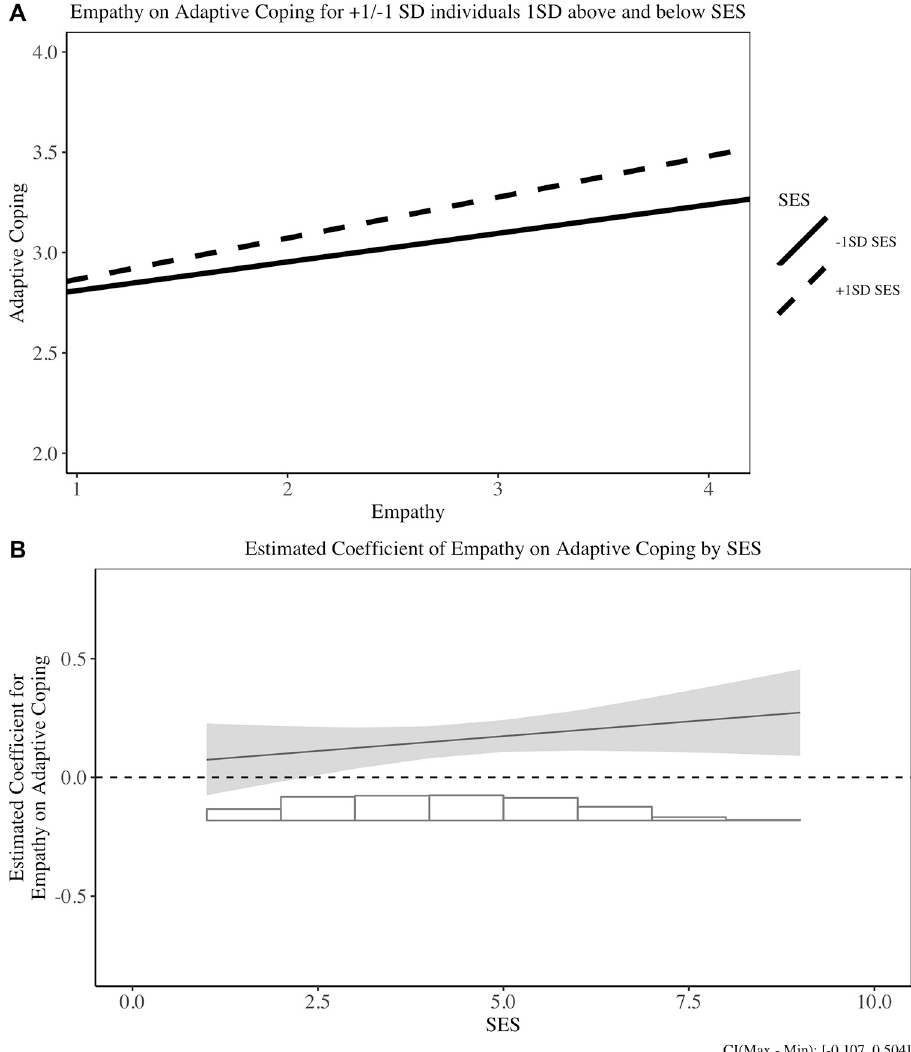
Fig 1. Relationship between empathy and adaptive coping in Study 1. (A) Simple slope result for +/- 1SD SES individuals on adaptive coping. (B) Estimated coefficient of empathy on adaptive coping for different SES individuals.